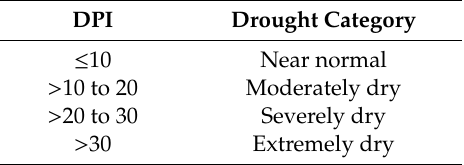
Table 4. Classification of meteorological drought expressed by dry period index